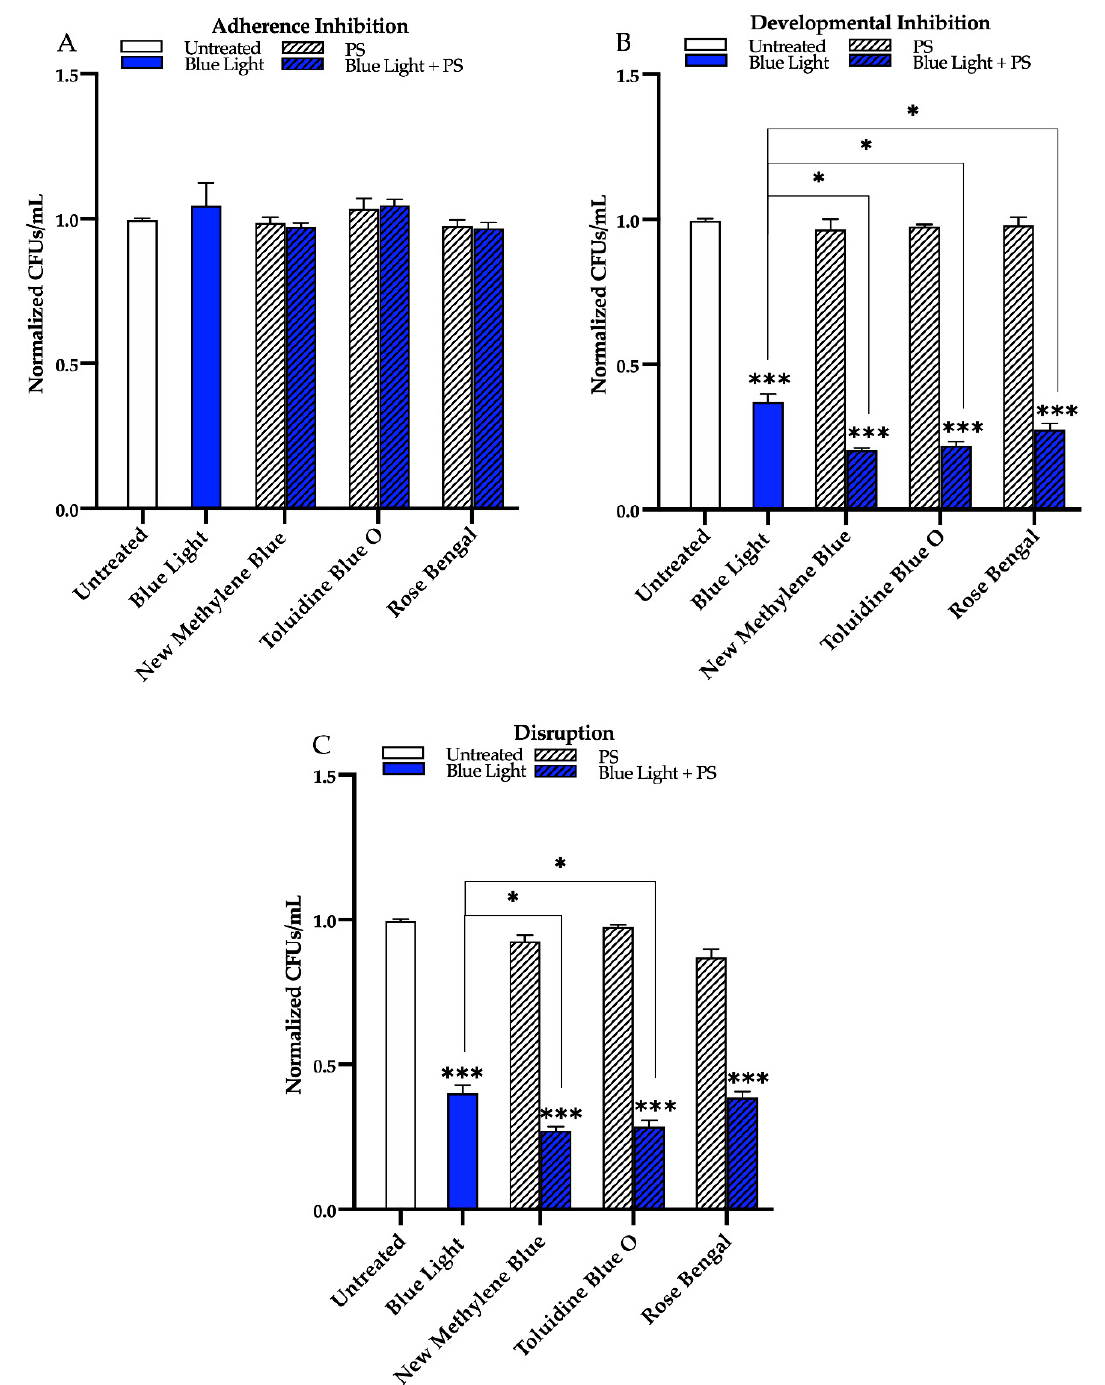
Figure 5. Effects of blue visible light in combination with the photosensitizing compounds new methylene blue, toluidine blue O, and rose bengal on C. albicans biofilms. Effects of blue light in combination with the photosensitizing compounds in the ( A ) adherence inhibition, ( B ) developmental inhibition, and ( C ) disruption biofilm assays. Untreated control (Untreated), blue light alone (Blue Light), photosensitizing compound alone (PS), and blue light in combination with the photosensitizing compound (Blue Light + PS) are shown. Colony forming units per 1 mL (CFUs/mL) were measured to determine viable cell counts from the biofilms at the end of each biofilm assay. Standard deviations are shown for each sample ( n = 3). The average CFUs/mL of the untreated control samples for each assay were normalized to 1. Significance comparisons are relative to the untreated control unless otherwise noted with significance bars and were determined using Student’s unpaired two-tailed t-tests assuming unequal variance for p ≤ 0.05 (*), and p ≤ 0.001 (***).